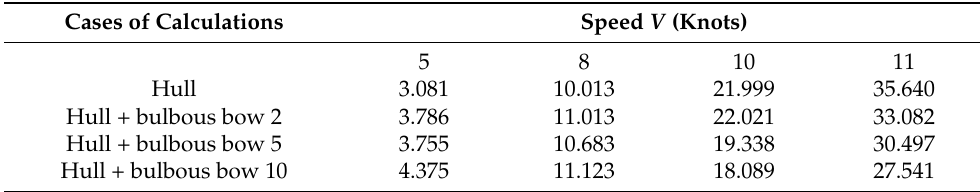
Table 4. Hull resistance (kN) for fishing vessel with added O-shaped bulbous bow, for three types of bulbous bows and different speeds.